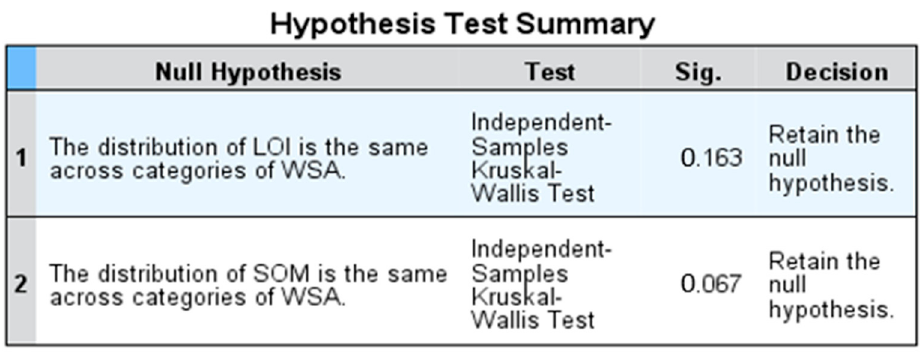
Figure 4. Boxplot comparing the ranges of LOI, SOM and WSA in each land use classification.